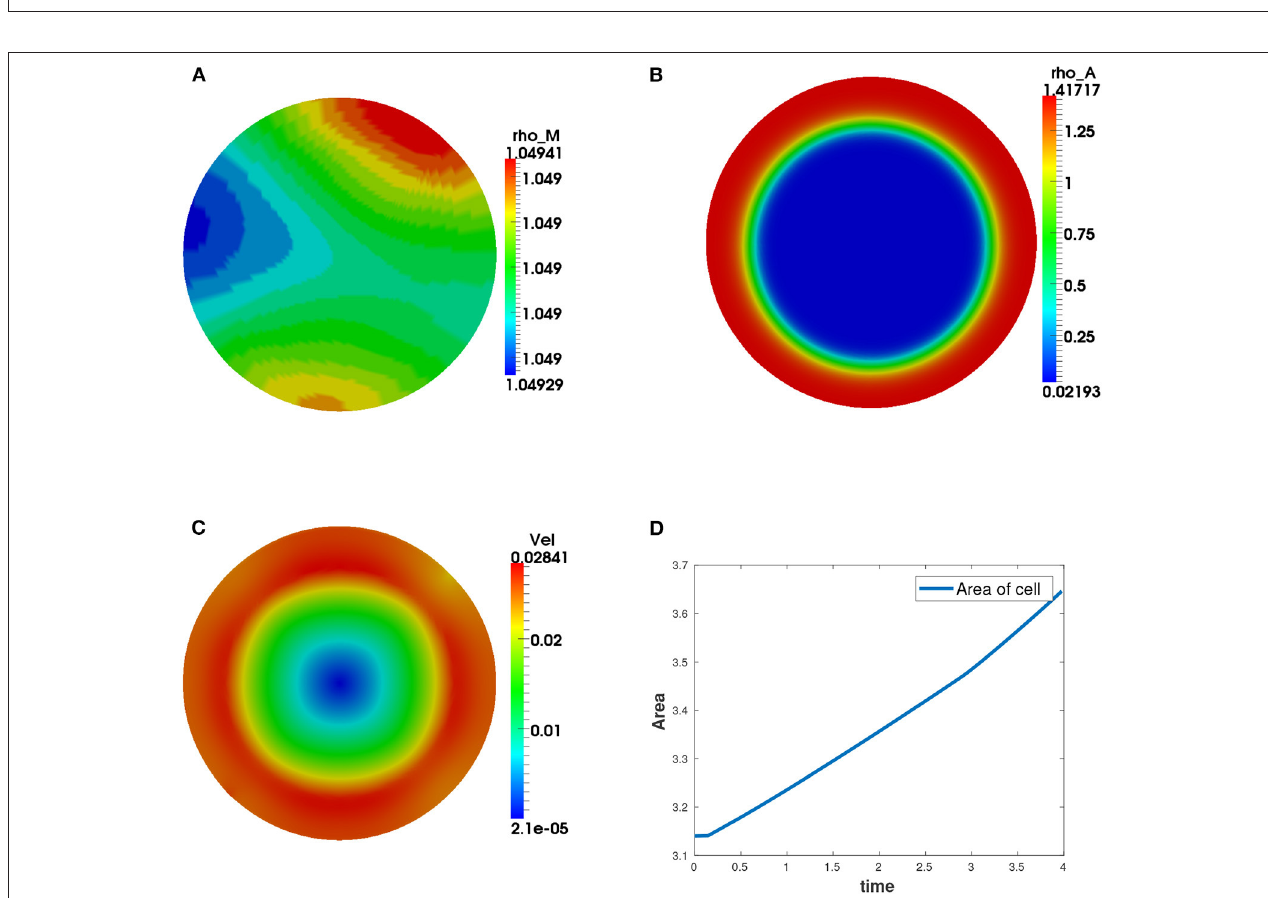
FIGURE 2 | Graphical display of numerical solution illustrating a growing cell at time t = 4. This is a case when considering initial condition as random perturbations about ρ a = ρ m = 1.0. Blue signifies lowest values while red signifies highest values. (A) solution for ρ m variable, (B) solution for ρ a variable, (C) cell speed at final time showing higher speeds as the concentration of F-actin increases, and (D) area of the growing cell as a function of time showing increase in area of the cell with